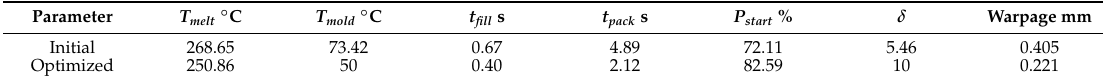
Table 12. Conventional parameters and warpage results of the PC/ABS phone cover.